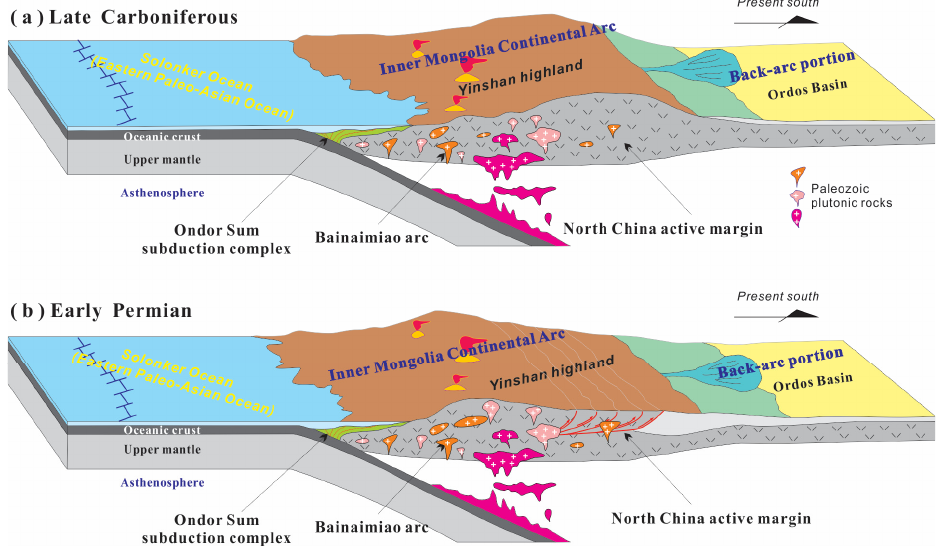
Figure 11. Schematic model showing the paleogeographic transition in the western North China Block during Carboniferous and Early Permian (modified from Sun and Dong [2]). Notes: The Carboniferous sources of the Ordos Basin were dominated by the NCB basement with rare supply from arc magmatic rocks ( a ), whereas uplift of the Inner Mongolia Continental Arc triggered a large volume of sediment influx by eroding Paleozoic arc pluton bodies since the Early Permian deposition of the Shanxi Formation ( b